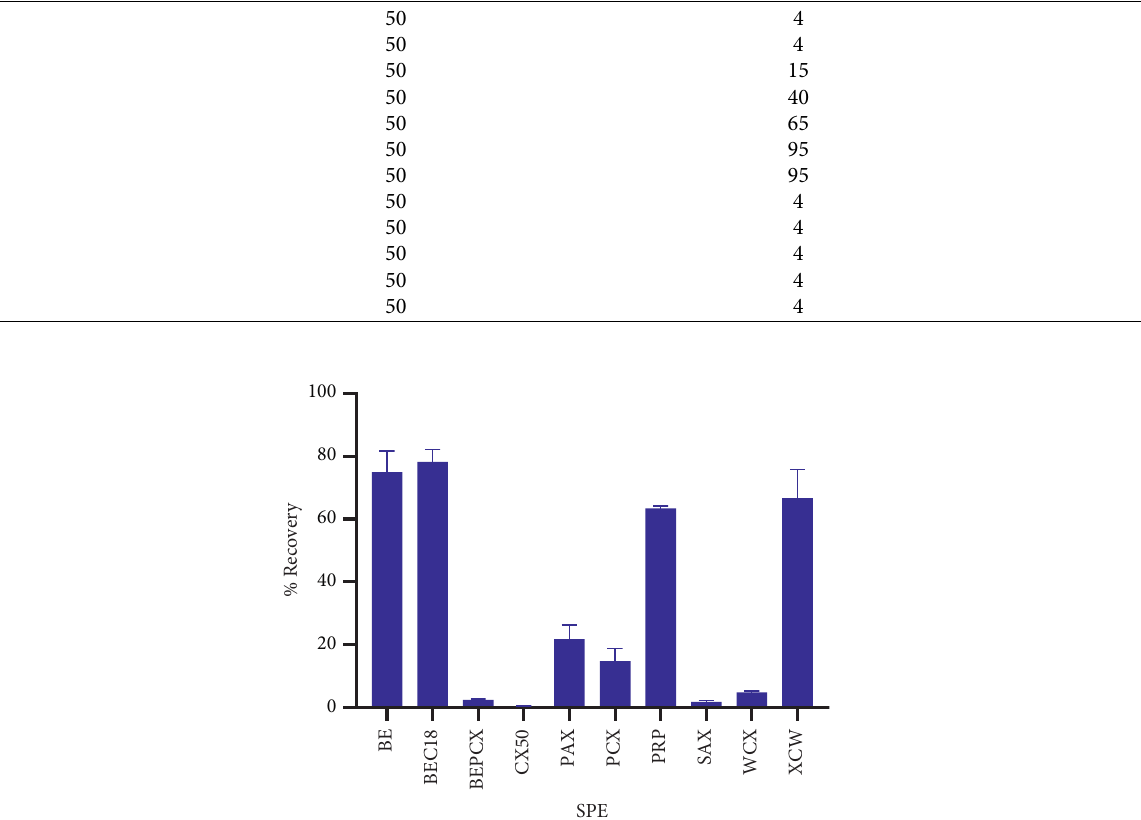
Figure 1: Product ion spectra of dabigatran (a) and 13 C in the structures.